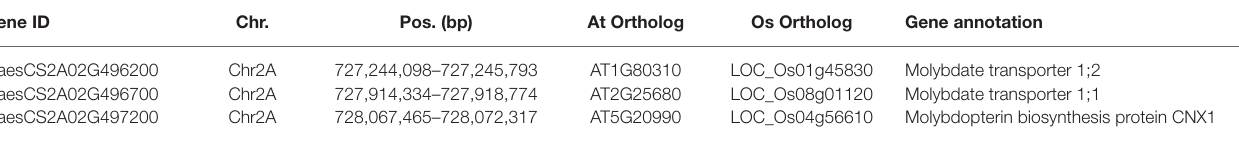
TABLE 3 | Potential candidate genes underlying GMoC trait in